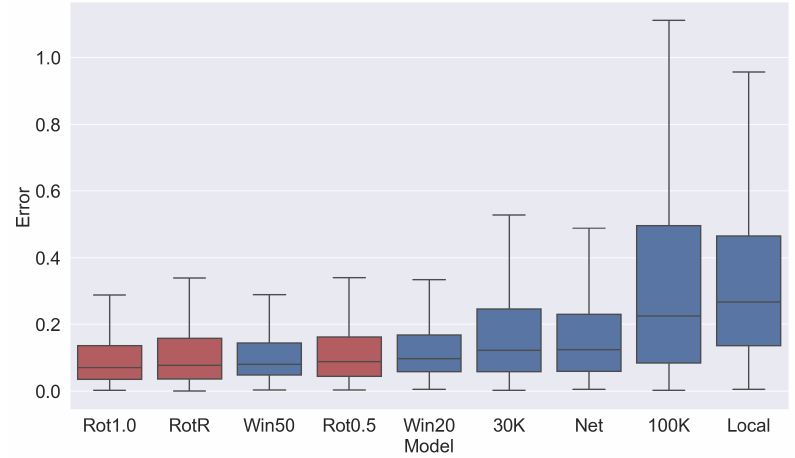
Figure 8. Rotation estimation error using the same selection strategy for training. Red bars indicate train-only results (cannot be used in a real system), while blue bars can be used for both training and inference.